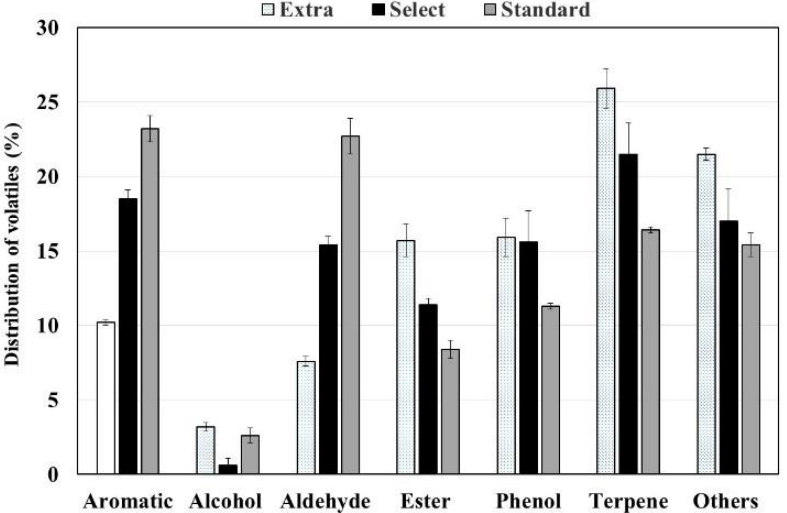
Figure 5. Distribution (%) of chemical families of VOCs in Californian-style black olives stuffed with hydrocolloids.